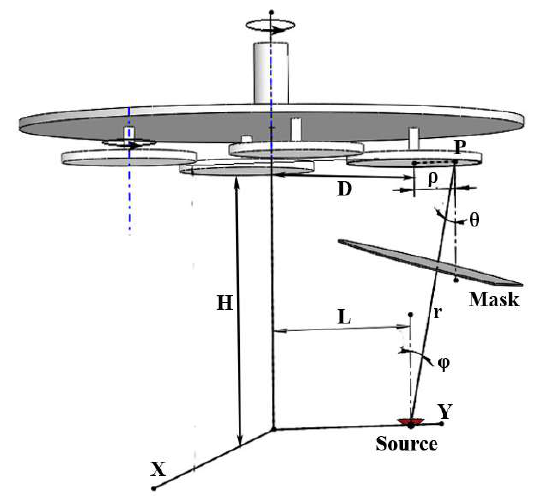
Figure 24. Planetary substrate holder with mask, where H is the distance between the source and the top of the substrate holder; ϕ is the angle between the normal of the source and the line connecting the source to the P point; θ is the angle between the normal of the substrate and the line connecting the source to the P point; ρ is the distance from the center of the substrate holder to the P point; r is the distance from the source to the P point; L is the distance from the source to the center; D is the distance from the main axis to the planetary axis; and P is any point on the substrate holder, ( L = 400 mm, H = 830 mm, D = 310 mm, ω 1 = 3 π , ω 2 = 4 π